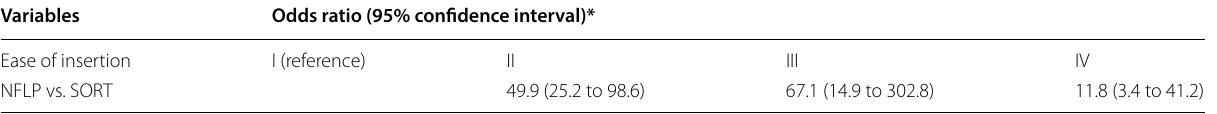
Table 3 Multivariable analysis of the ease of insertion stages and NGT insertion